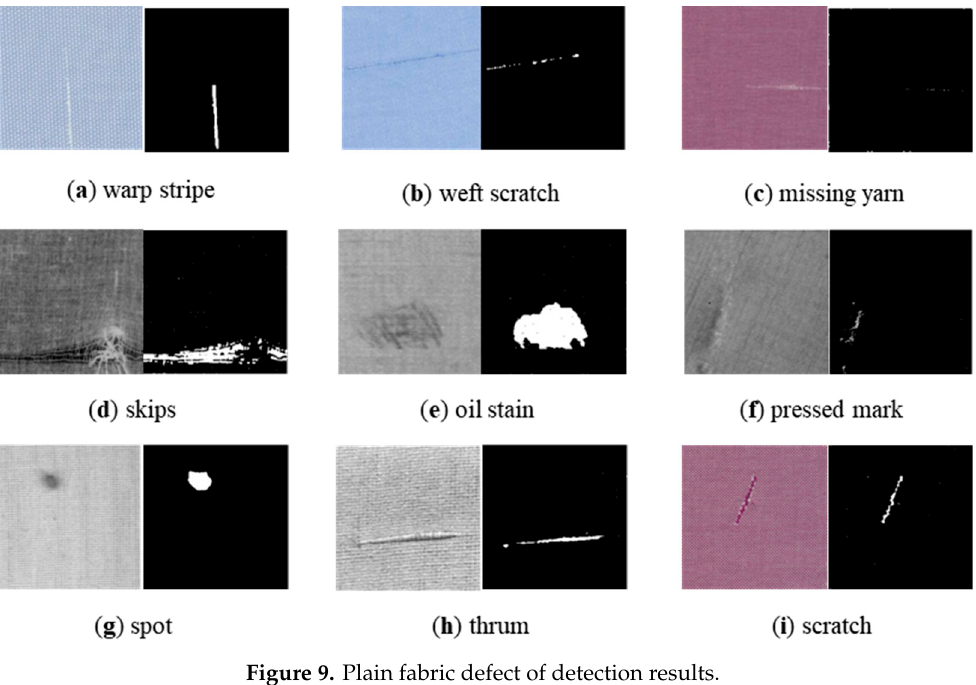
Figure 9. Plain fabric defect of detection results.